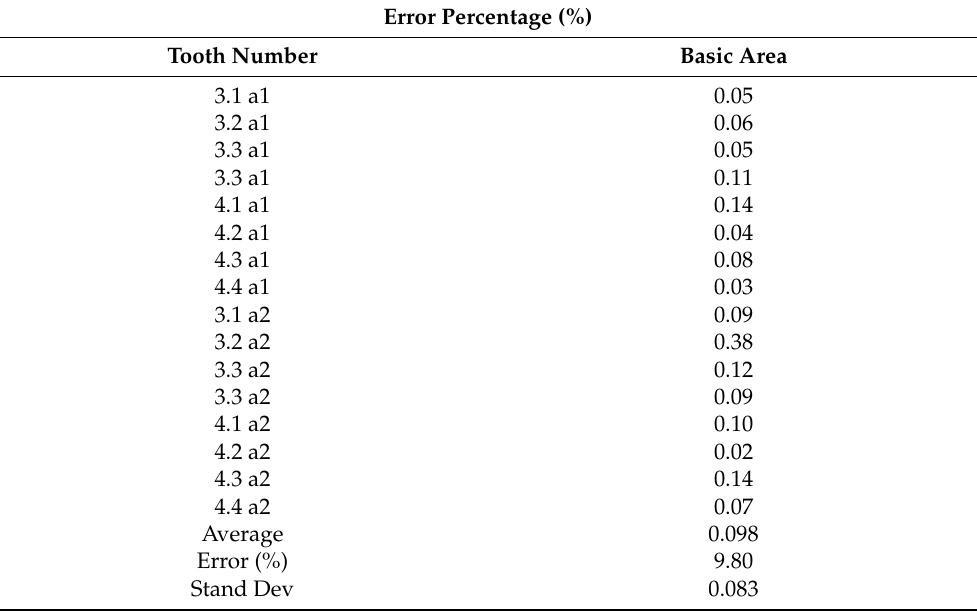
Table 2. Percentage error calculated through the ratio between the base area of the natural tooth and the prototype.